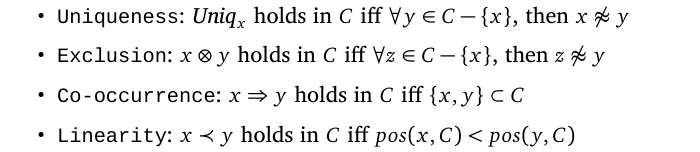
Properties’ operational